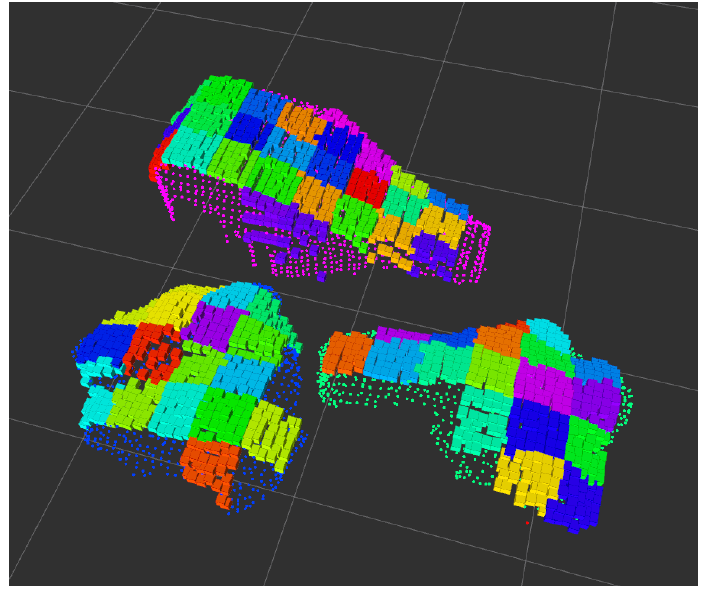
Figure 9. Example of the sub-regions generated by processing a segmented point cloud with three distinct rocks. The coloured groups of voxels on the surface of the point cloud represent each of the generated